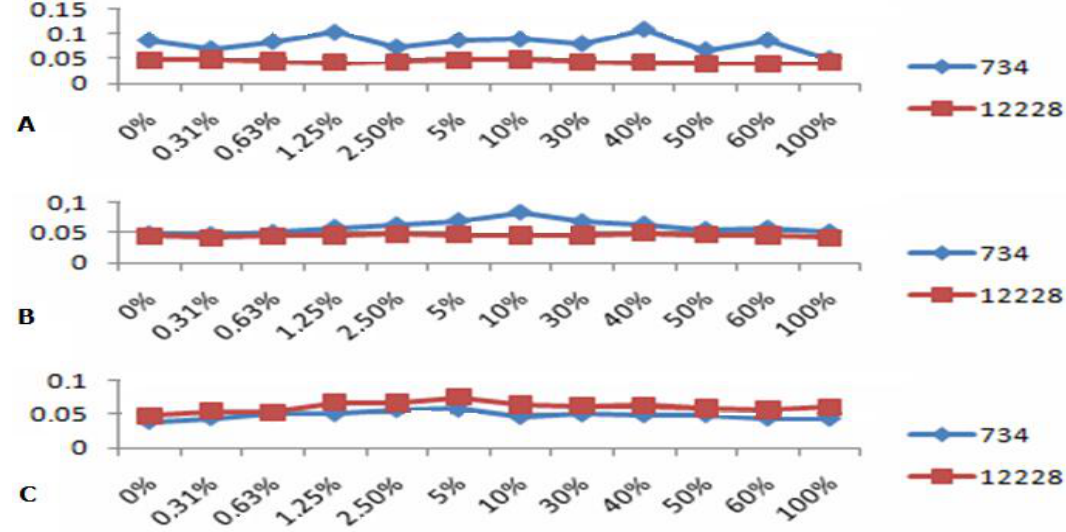
Figure 4. Biofilm susceptibility to maggot ES. A. After incubation time 2 h, B.After incubation time 24 h, C. After incubation time 48 h. Examination in duplo performed using MTT assay. Horisontal line indicated concentrations of ES, whereas vertical line indicated biofilm